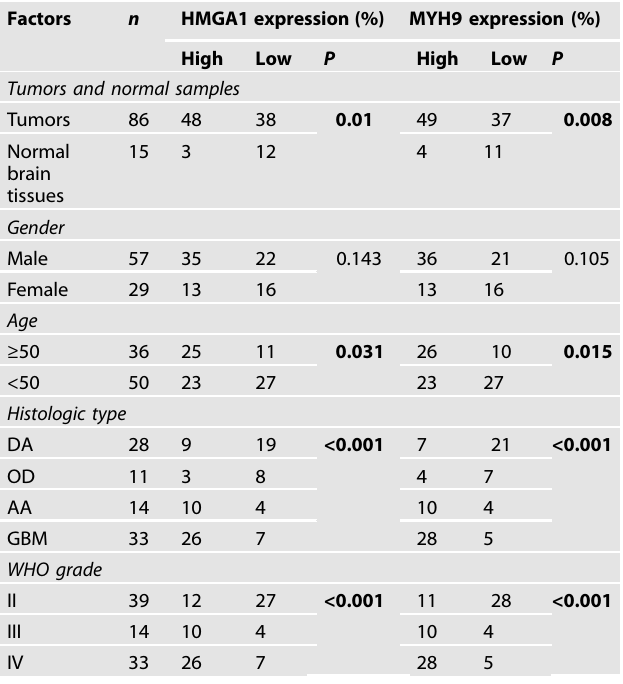
Table 1. Correlation between the clinicopathologic factors and expression of HMGA1 and MYH9 in glioma.